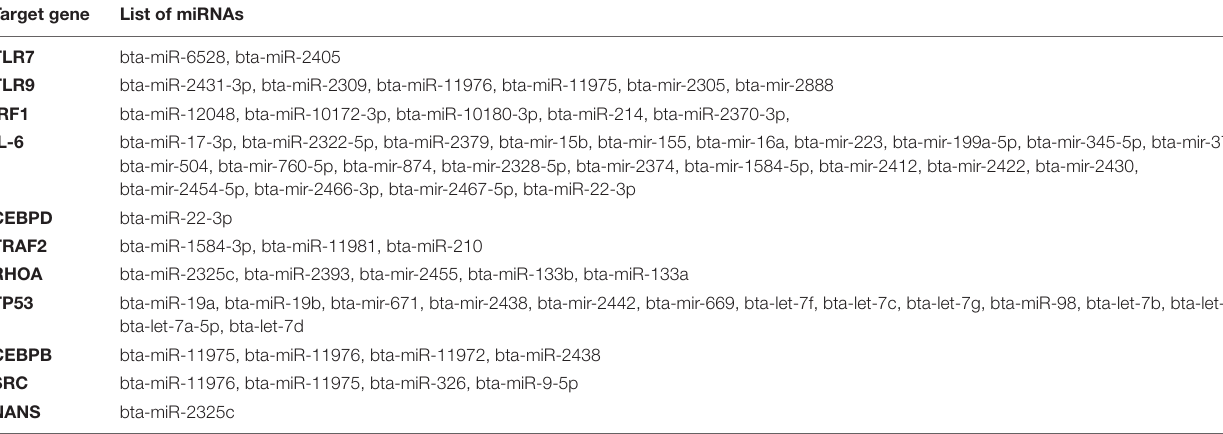
TABLE 2 | List of miRNAs predicted by miRBase, miRNet, or TargetScanHuman for the 11 significant genes. Target